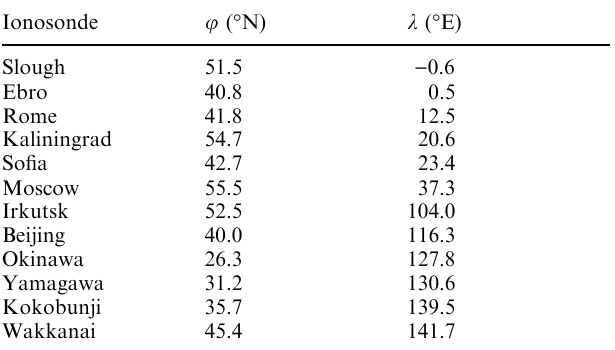
Table 1. List of ionosondes with their coordinates, geographic latitudes ( (cid:117) ) and geographic longitudes ( (cid:107) )